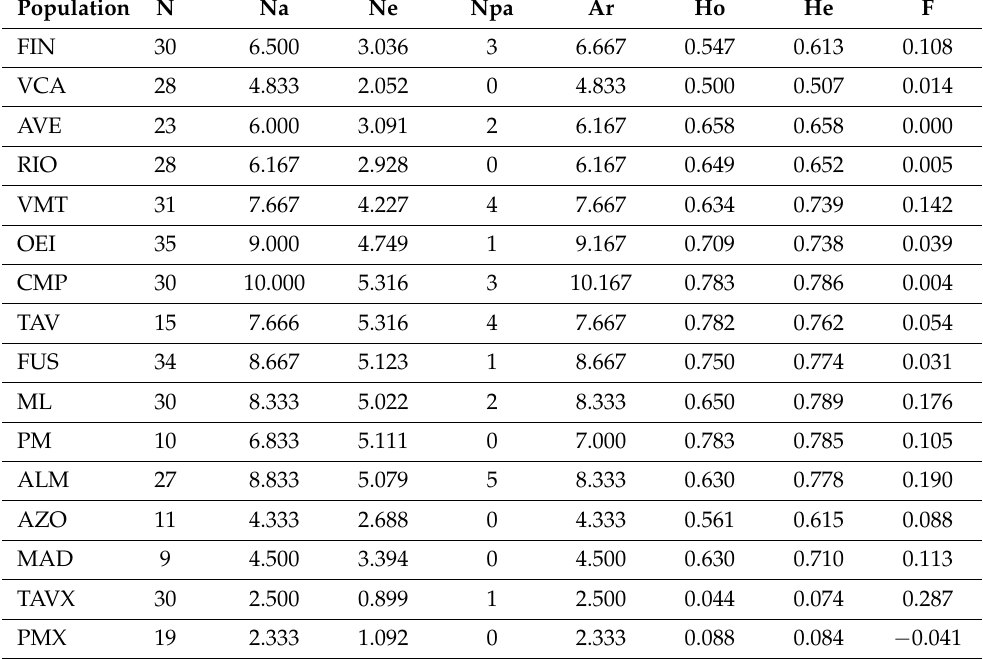
Table 2. Genetic diversity of the 16 wild beet populations, based on the polymorphisms of six SSRs loci: N—number of plants; Na—number of alleles; Ne—number of effective alleles; Npa— number of unique alleles to a single population; Ar—allelic richness; Ho—observed heterozygosity; He—expected heterozygosity; F—fixation index (inbreeding